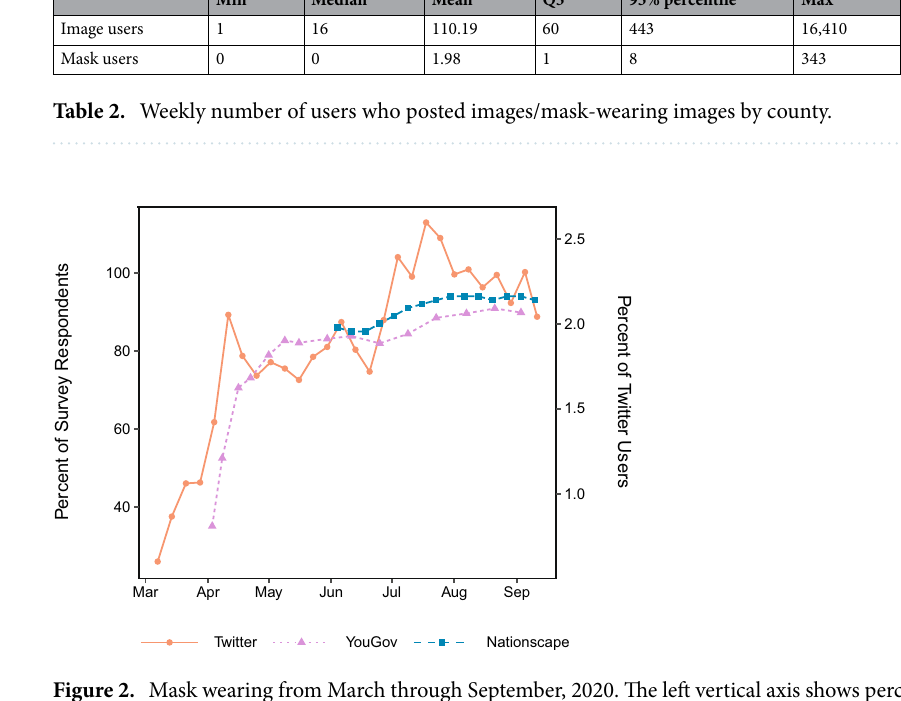
Figure 2. Mask wearing from March through September, 2020. The left vertical axis shows percentage of survey respondents who reported wearing a mask in public. The right vertical axis shows the percentage of Twitter users who posted a mask image (among those who posted at least one image in a geotagged